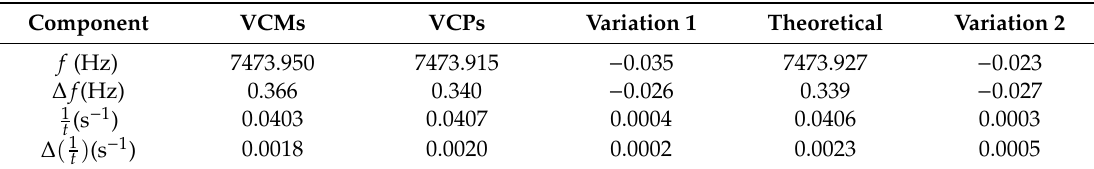
Table 5. Results and comparisons among the theoretical vibrational characteristics, the VCPs, and the